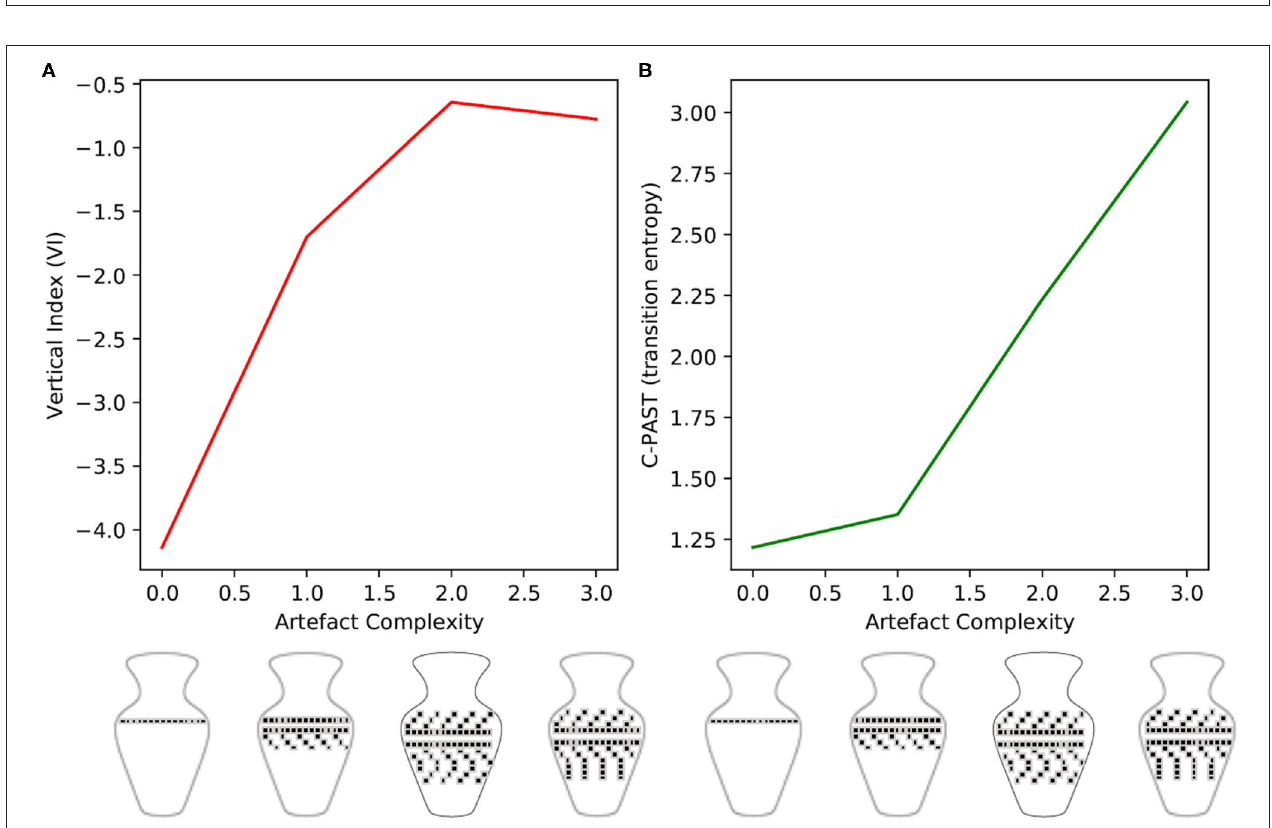
FIGURE 3 | (A) The effect of artefact complexity on the vertical index (Vi) measure of scan paths. Consistent with the empirical findings of Criado-Boado et al. (2019), we find that artefactual complexity positively correlates with Vi (B) . The effect of artefact complexity on the C-PAST measure of learned generative models. As described in the main text, this measure quantifies the entropy of the motif-transition parameters “B2,” which are learned over the course of the 100 trials. These results demonstrate that artefact complexity correlates positively with C-PAST, highlighting the symmetry between environmental complexity and model